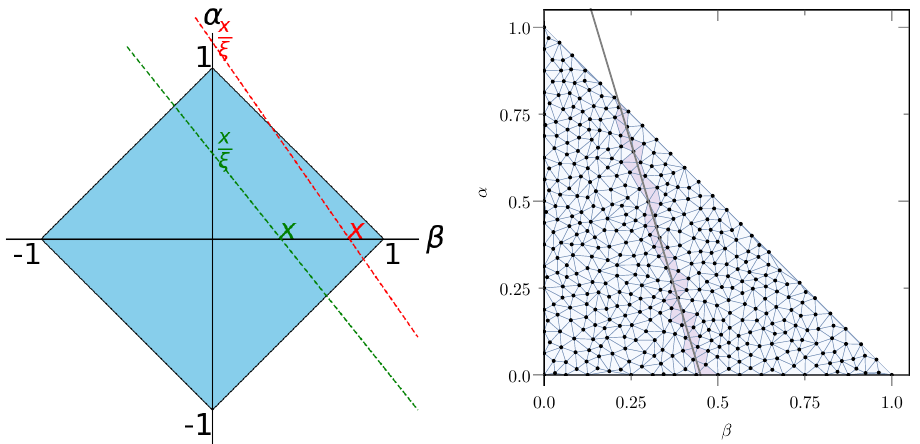
Figure 10. Left : Support of the DD and example of a DGLAP line (red) and ERBL line (green). Right : Support of the DD F after tessellation using a Delaunay mesh. An example of a DGLAP line is given. If numerous enough, those lines can probe every cell of the DD support. Figure from